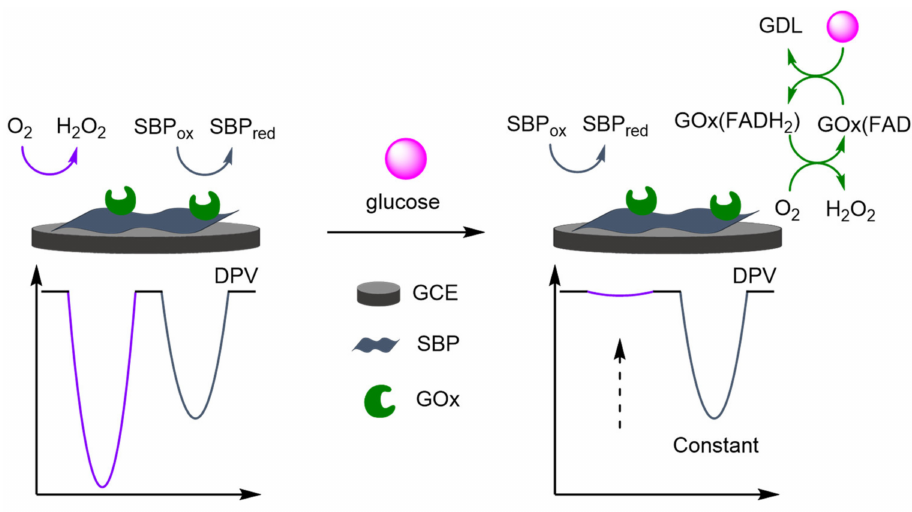
Figure 43. Schematic representation of a Schiff base polymer-supported biosensor for the detection of